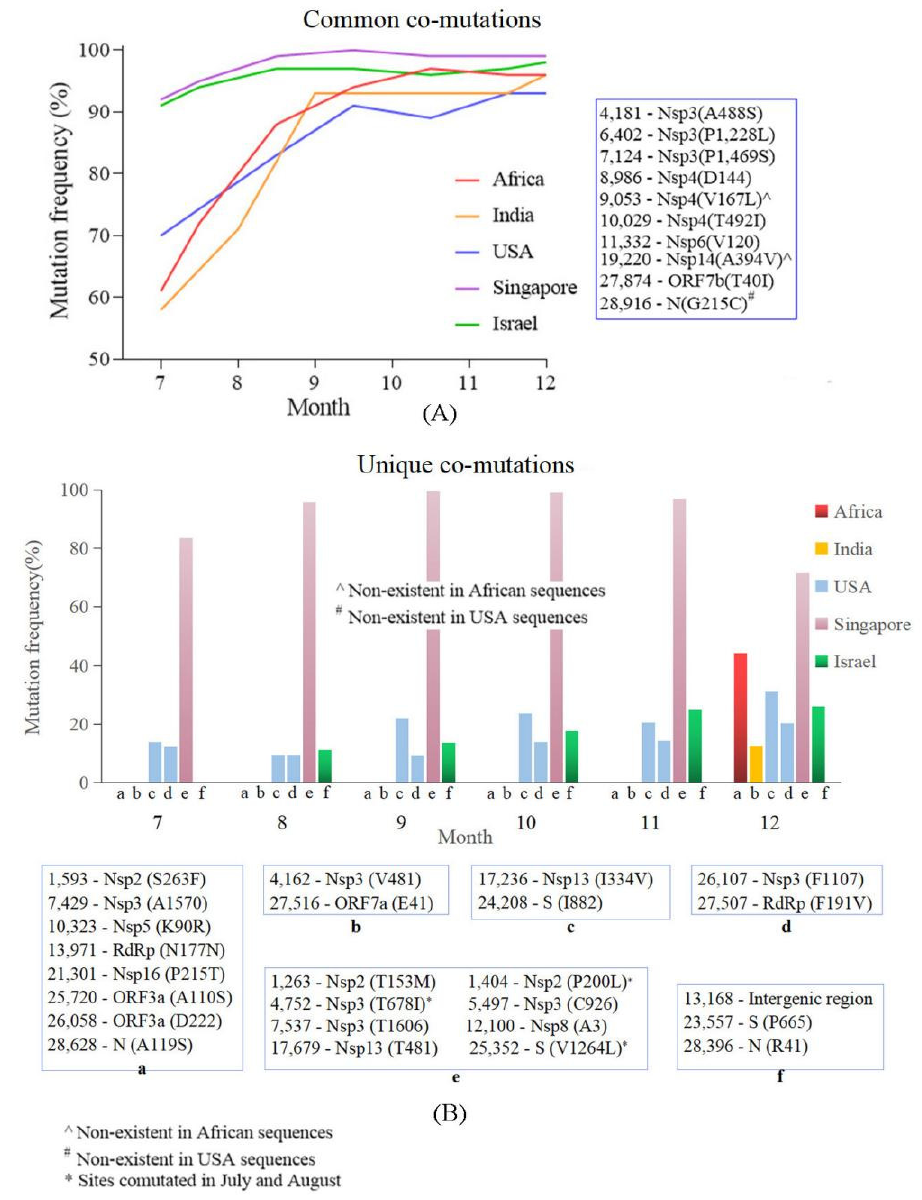
Figure 4. Comparisons of co-mutations patterns in different countries/regions. ( A ) Common co-mutation in the five areas. The proportion of this set of co-mutations increased over time and was extremely high in Singapore and Israel. ( B ) Unique co-mutations in different areas. Six groups (group a–f) of unique co-mutations were detected. Groups a and b were only found in December. The proportions of group c, d and e gradually increased over time. Group e was detected in Singapore throughout the six months with highly occurring